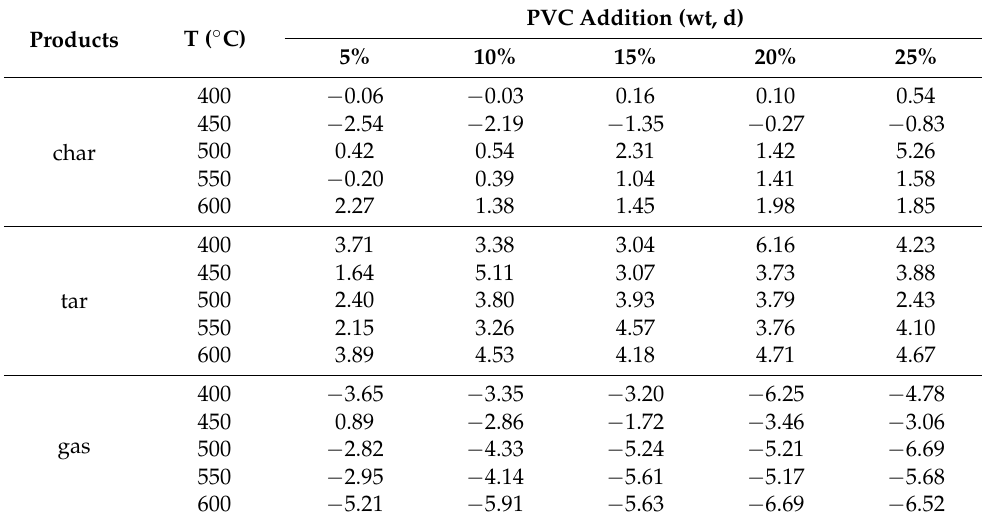
Table 4. Actual and theoretical difference in pyrolysis product yield at different temperatures and PVC